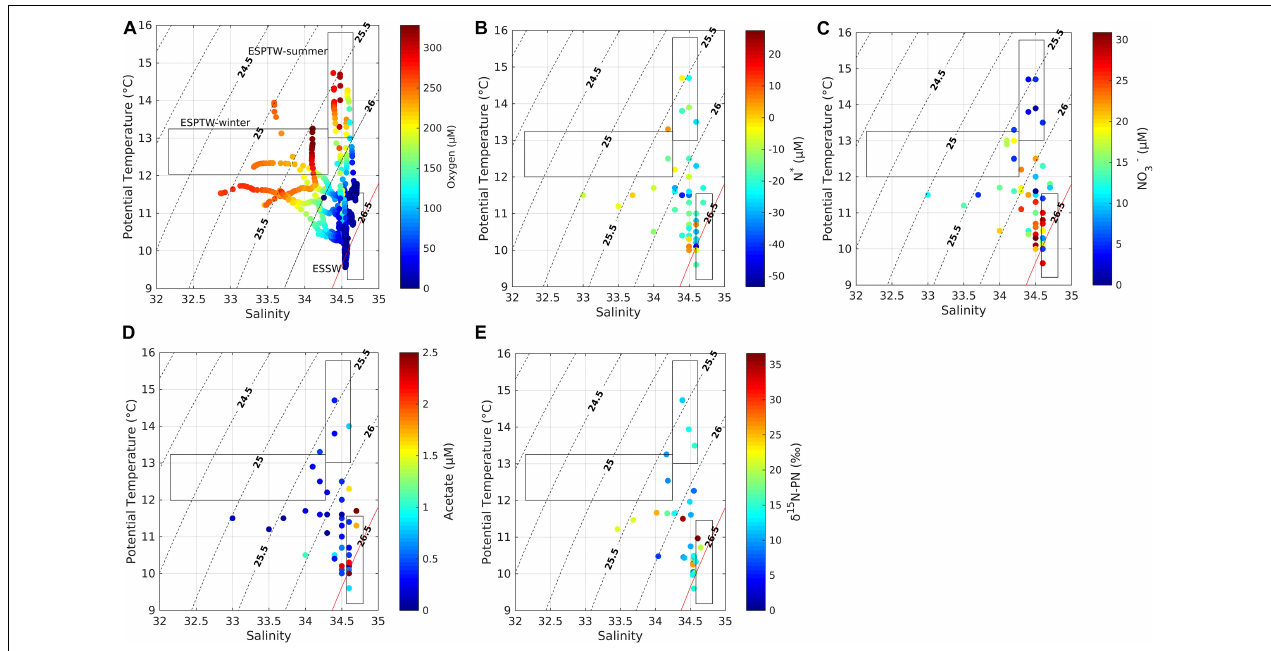
FIGURE 3 | Potential temperature/salinity diagram from depth profiles taken at Station 18, off Concepción; data points are color coded (see color bar) for the following measurements (A) oxygen, (B) N ∗ , (C) NO 3 − , (D) acetate, (E) δ 15 N-PN. N ∗ = [NO 3 − + NO 2 − + NH 4 + ] – 16 [PO 4 + 3 ] + 2.9 (Hansell et al., 2004), PN, particulate nitrogen. Rectangles indicate temperature and salinity ranges for Equatorial Subsurface Water (ESSW), and Eastern South Pacific Transition Water (ESPTW) in austral winter and summer. Dotted lines represent isopycnals as sigma-t and red line corresponds to sigma-t of 26.5 in the core of